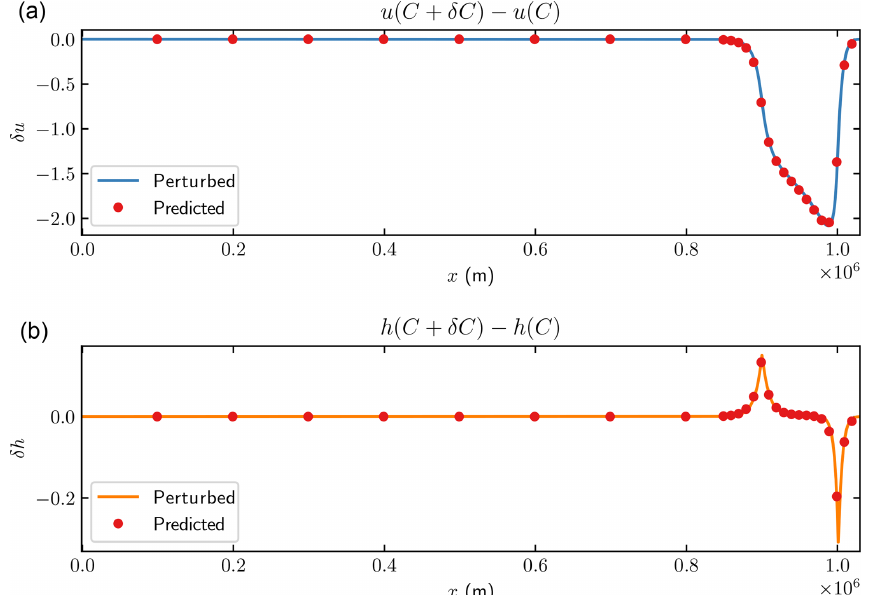
Figure 10. The changes in the horizontal velocity u (a) and surface elevation h (b) for SSA after 1 year with 1% perturbation of C(x) in x ∈ [ 0 . 9 , 1 . 0 ]× 10 6 m. Solid lines are the differences between the steady-state and the perturbed solutions in Eq. (13). Red dots represent the estimated perturbation using Eq. (15).